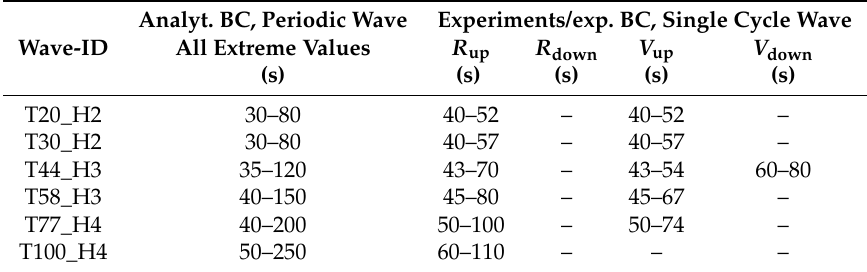
Table 3. Time intervals (in seconds) which were used for the computation of the extreme values in Figures 9 and 10.